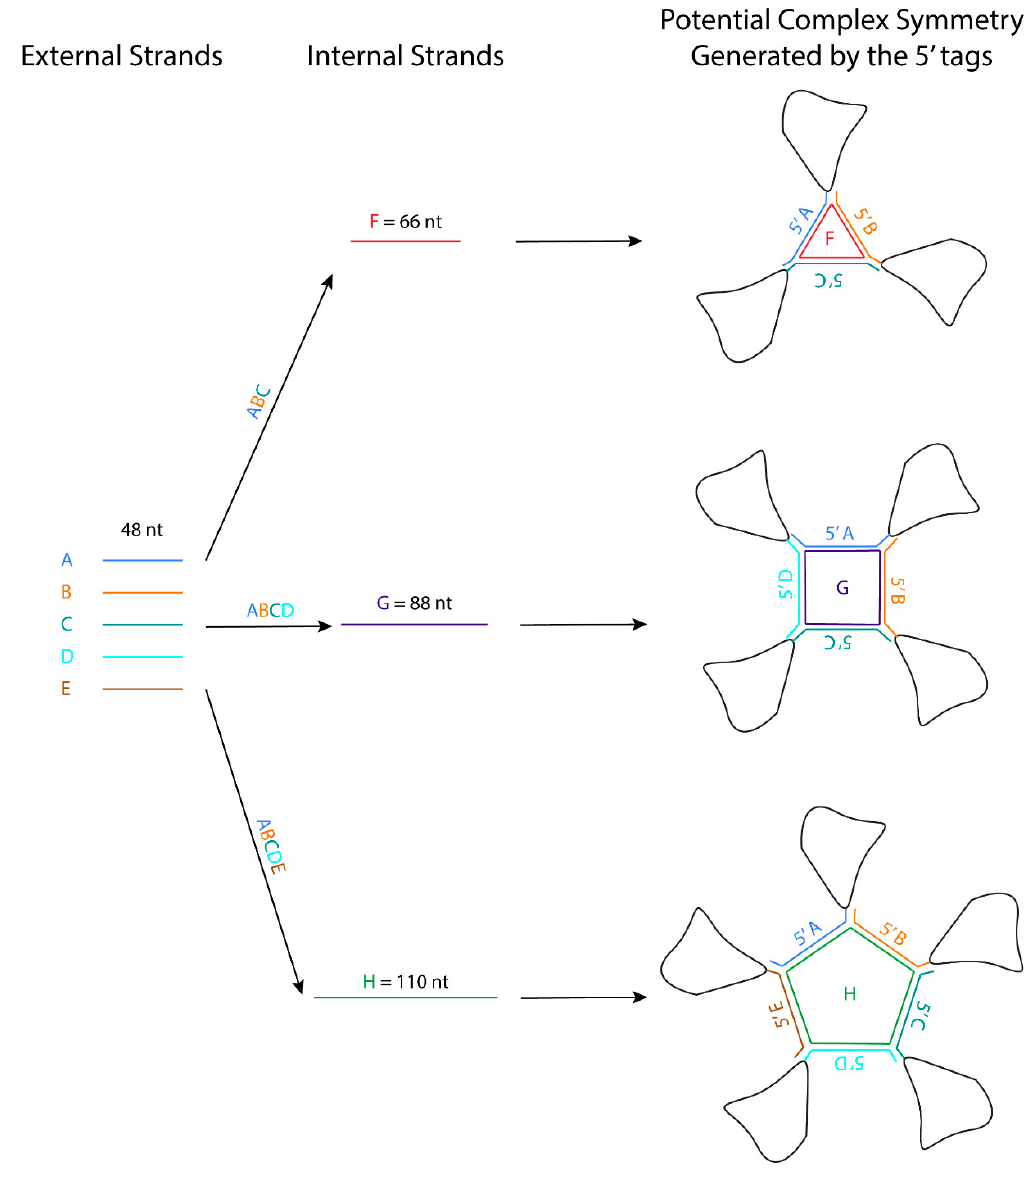
Figure 2. Potential symmetry generation using 3WJ junction forming oligonucleotides (Adapted from Khisamutdinov et al., 2014 [117]). External strands can be cloned into the 5 ′ end of a complex. Internal strands can be supplied into the sample to induce polygon formation.